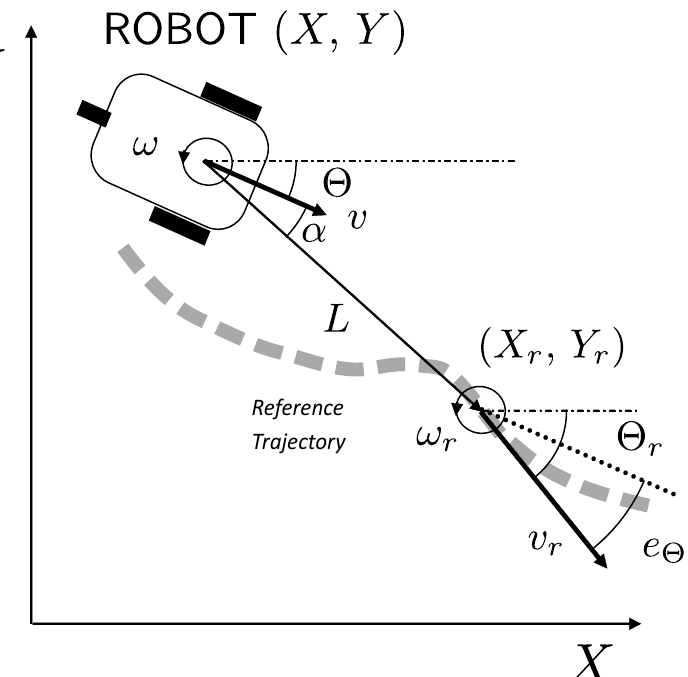
Figure 3. Main variables describing the trajectory tracking problem: current robot pose ( X , Y , Θ ) , reference pose to be tracked ( X r , Y r , Θ r ) , distance error L and angle error α